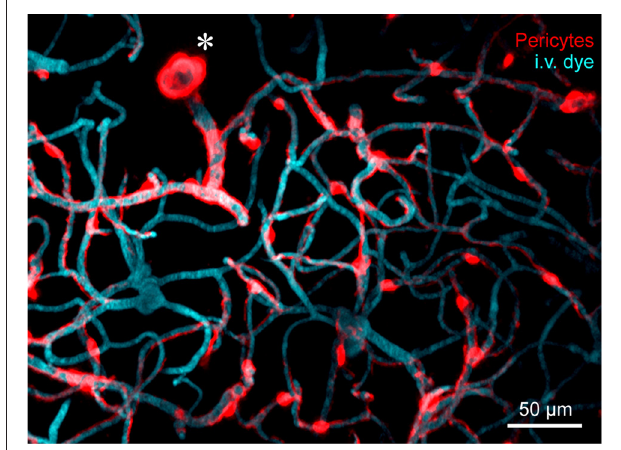
FIGURE 1 | In vivo two-photon microscopy of adult mouse cerebrovasculature. High-resolution image of the capillary network surrounding a penetrating arteriole ( ∗ ) in the mouse cortex. Mural cells are labeled red through expression of tdTomato driven under the control of the Myosin heavy chain 11 (Myh11) promoter. The vasculature is labeled with intravenously administered 2-MDa FITC-dextran, and pseudo-colored blue. Many inducible and constitutively active Cre drivers are suitable for imaging brain mural cells. For more information, see Hartmann et al.